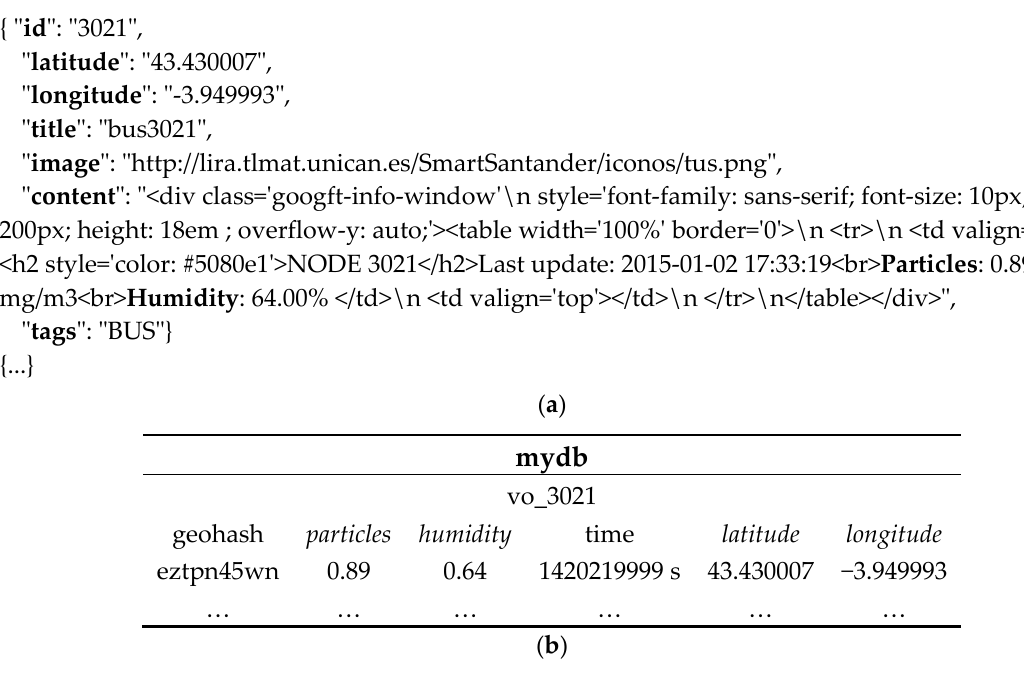
Figure 2. Example of Original Collected Data and its record in InfluxDB. ( a ) Example of Original Collected Data; ( b ) Example of Data Record in InfluxDB.